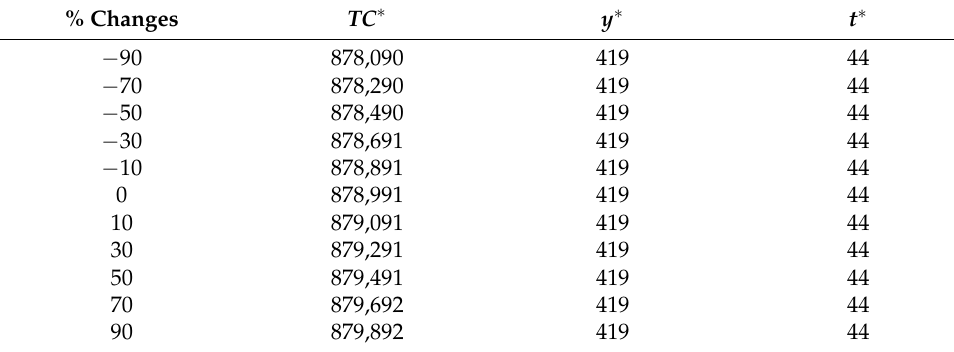
Table 2. Sensitivity analysis of the holding cost ( h ).